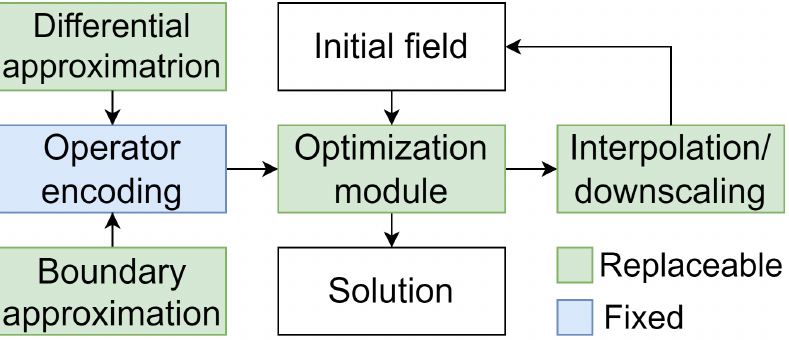
Figure 3. Module structure of the solver scheme (the green parts are